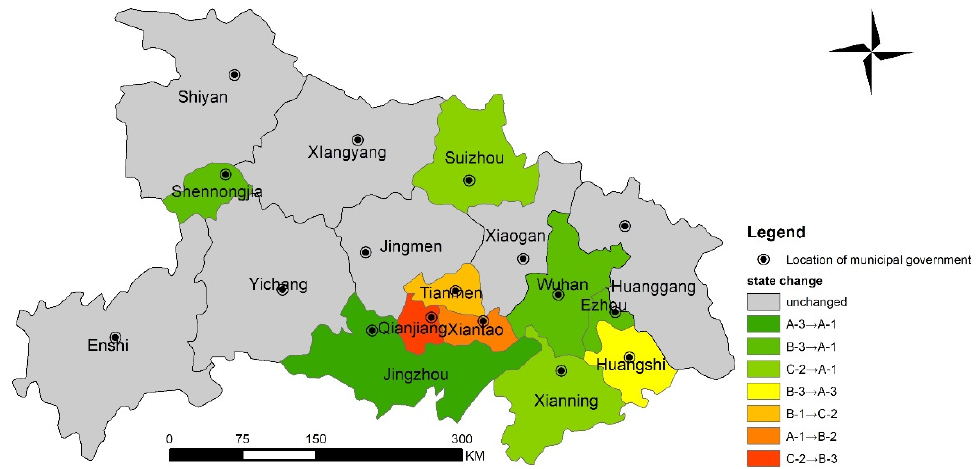
Figure 8. Decoupling states change between RECC and SCDI of Hubei Province during